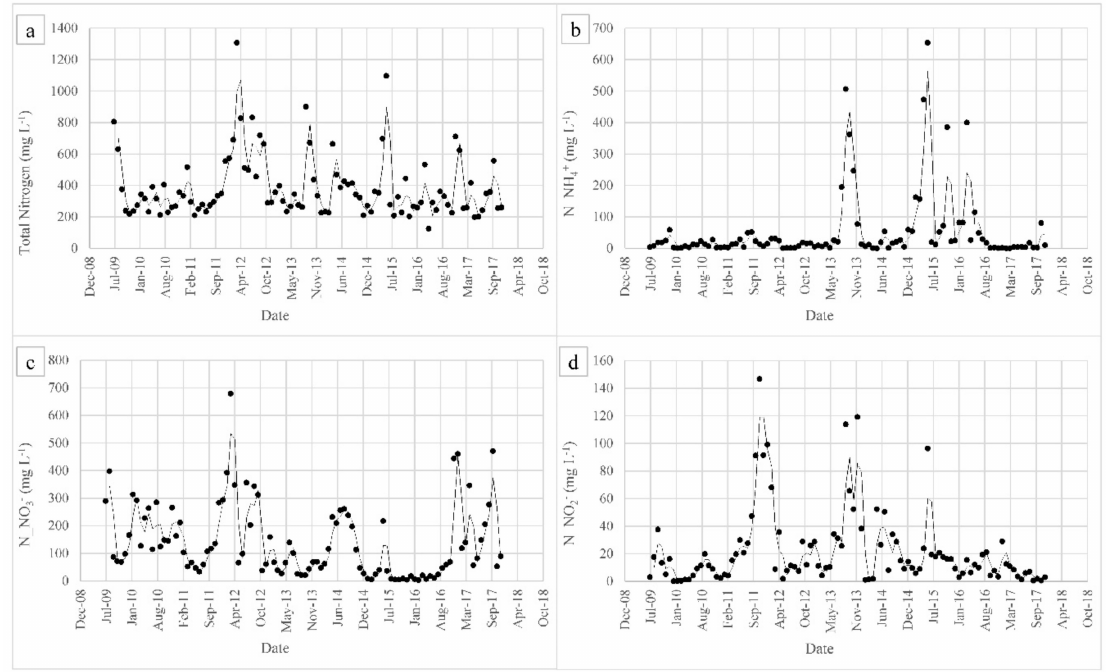
Figure 5. Concentration of nitrogen in the effluent of the side-stream plant: ( a ) TN, ( b ) N_NH 4+ , ( c ) N_NO 3 − , and ( d ) N_NO 2 −